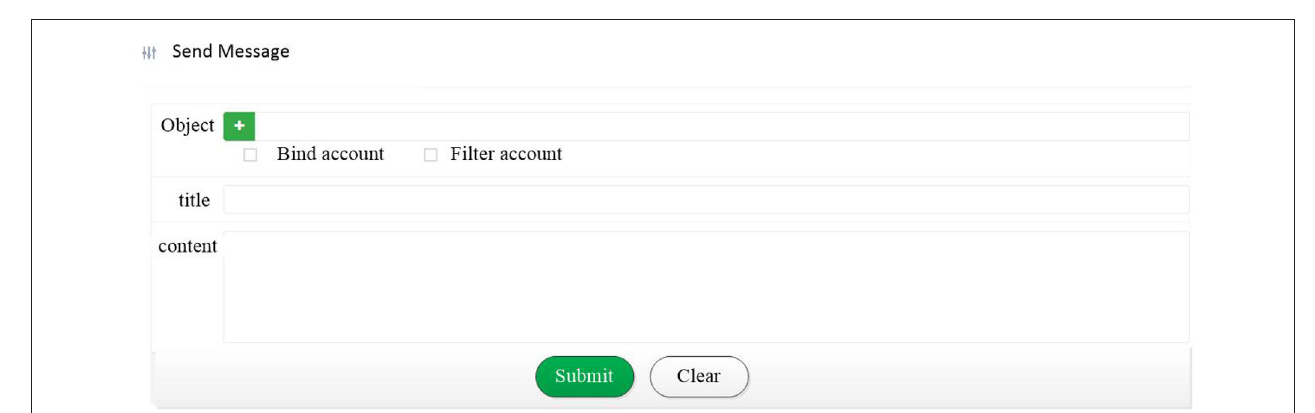
FIGURE 3 | Experimental analysis process.